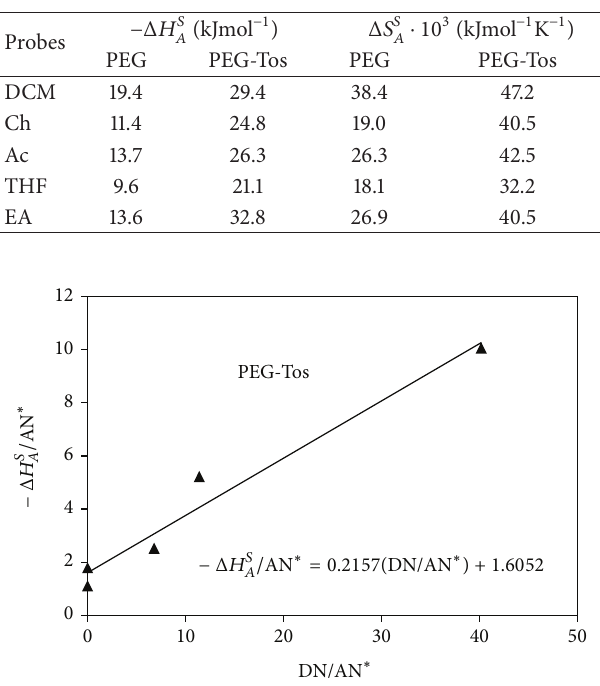
Figure 8: The plot of −Δ𝐻 𝑆 𝐴 / AN ∗ versus DN / AN ∗ for PEG-Tos.